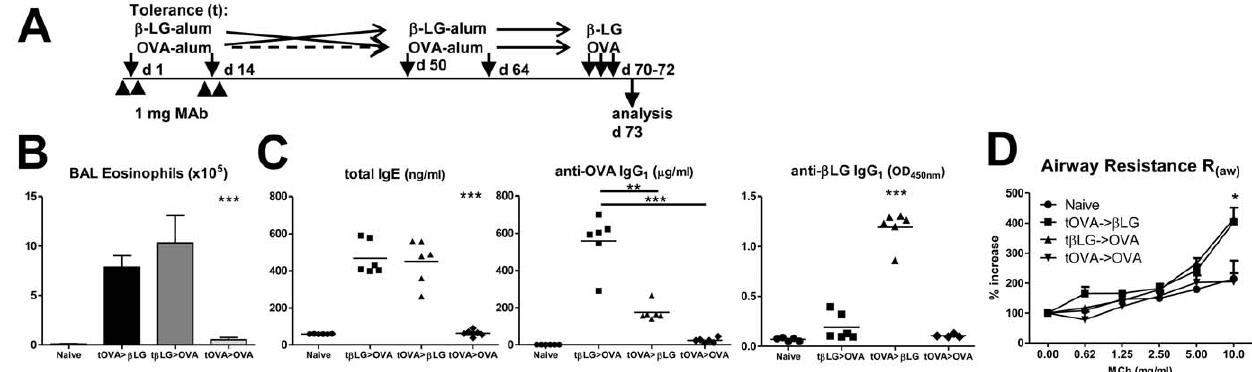
Figure 3. Mice treated with anti-CD4 are competent to respond to unrelated antigens. (A) Mice initially tolerized to OVA or b -LG (as described in previous figures) were sensitized i.p. with a different antigen at days 50 and 64, and challenged i.n. with the same antigen used at day 50. (B) Only animals tolerized to the same antigen used for sensitization at day 50 were protected from BAL eosinophilia (n=6, *** P , 0.001). (C) Tolerance induction to OVA did not prevent subsequent production of b -LG-driven IgE or IgG1, conversely, tolerance to b -LG did not hamper the generation of OVA-specific IgG1 or IgE (n=6, *** P , 0.001). (D) AHR in response to MCh was observed in animals tolerized to an antigen different from the one used for subsequent sensitization (tOVA . b -LG and t b -LG . OVA) (n=8, * P , 0.05 at 10 mg/ml MCh). Data are representative of two independent experiments.